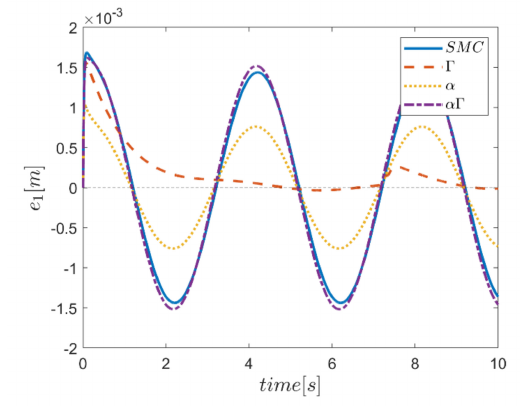
Figure 40. Tracking error in the x channel.